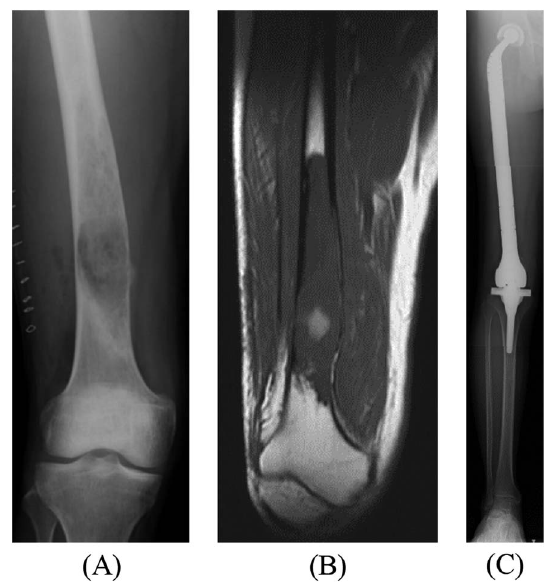
Figure 1. (A) X-ray of the right distal femur of 33-year-old man with a low-grade osteosarcoma. (B) Preoperative T1-weighted MRI showing the involvement of osteosarcoma in the distal two-third of the femur. (C) Radiograph demonstrating reconstruction of total femur after TFR.